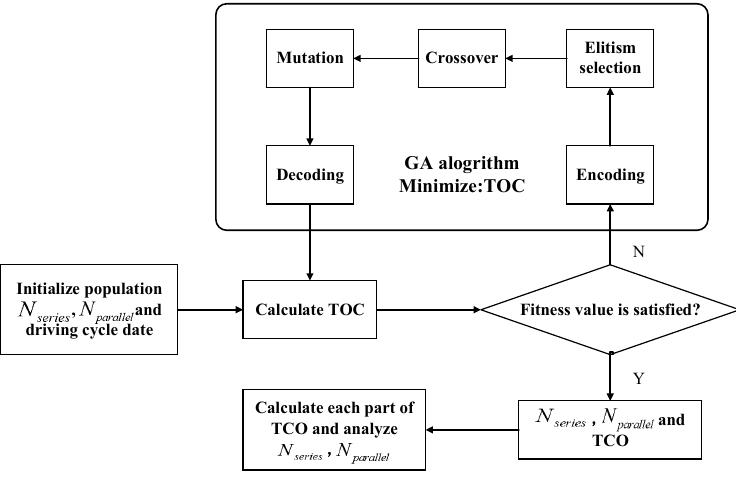
Figure 5. The optimization procedure using GA.